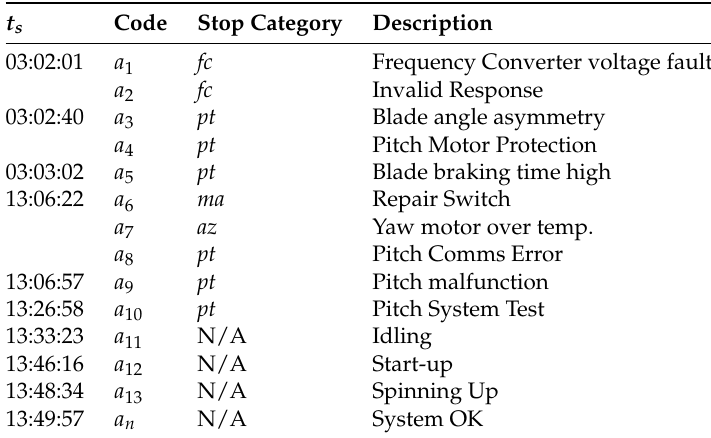
Table 4. Example of a batch of alarm